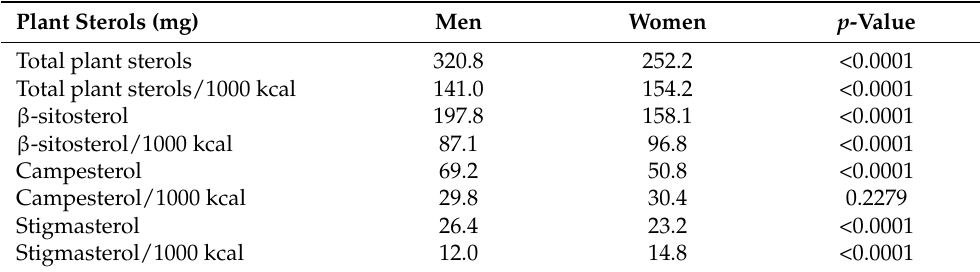
Table 6. Comparison of total and individual sterol intakes (in mg and in mg/1000 kcal) by men and